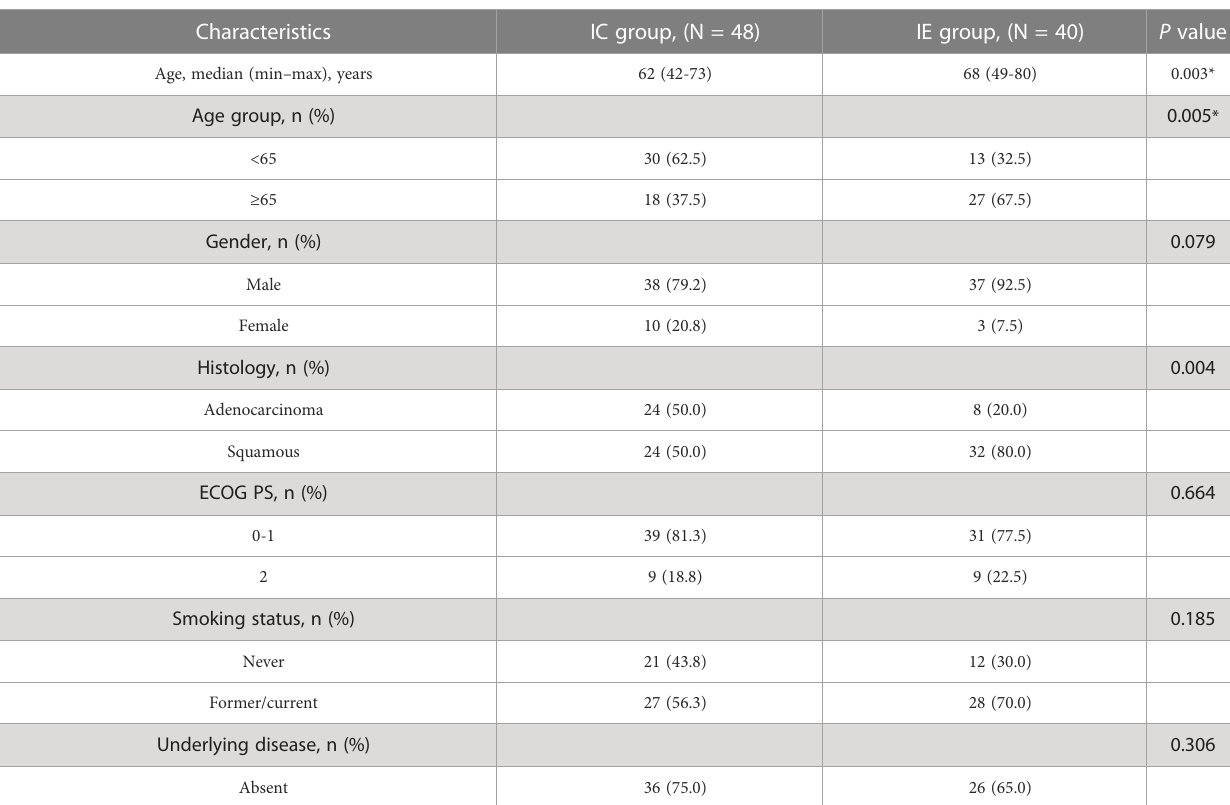
TABLE 1 Baseline